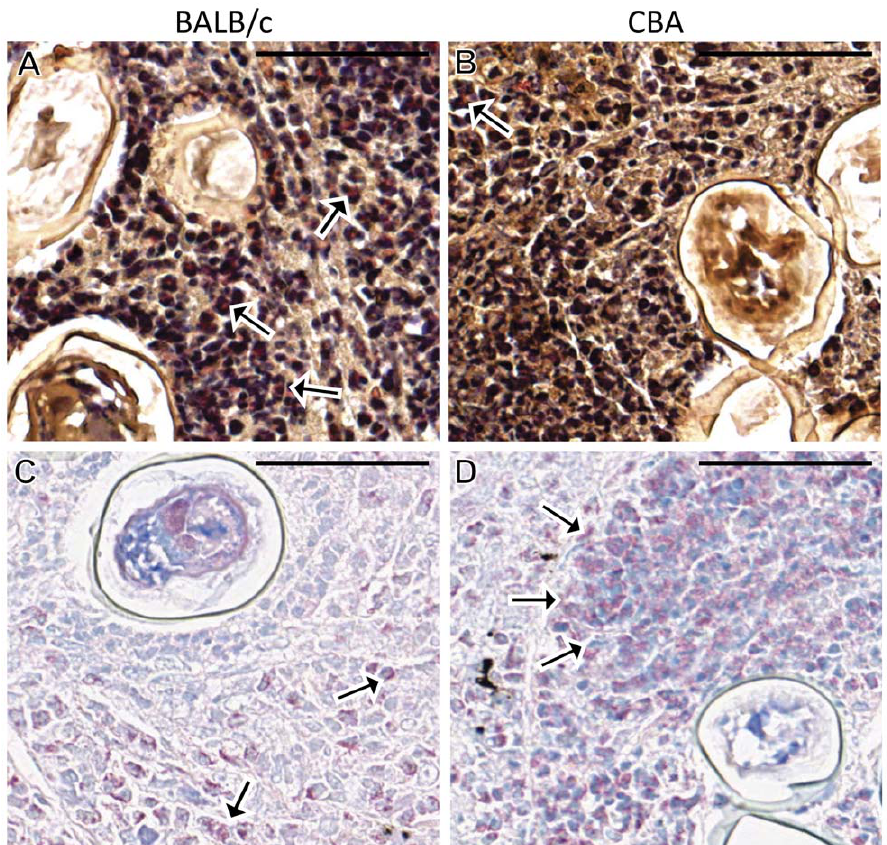
Figure 4. Cellular infiltration differs between BALB/c and CBA mice. Large areas of neutrophil accumulation (Leder stain; cells with pink cytoplasm indicated by arrows) adjacent to eggs were more common in BALB/c mice ( A ) compared with relatively scarce neutrophil accumulation in the granulomas of CBA mice ( B ). Conversely, large areas of eosinophil accumulation (Giemsa stain; cells with pink cytoplasms indicated by arrows) were more frequent in the granulomas of CBA mice ( D ) compared with those in BALB/c mice ( C ). All images were derived from mice at 7 weeks p.i. and were taken from murine livers with similar egg burdens and represent granulomas containing a similar number of eggs and at a similar stage of development. Scale bar=50 m m